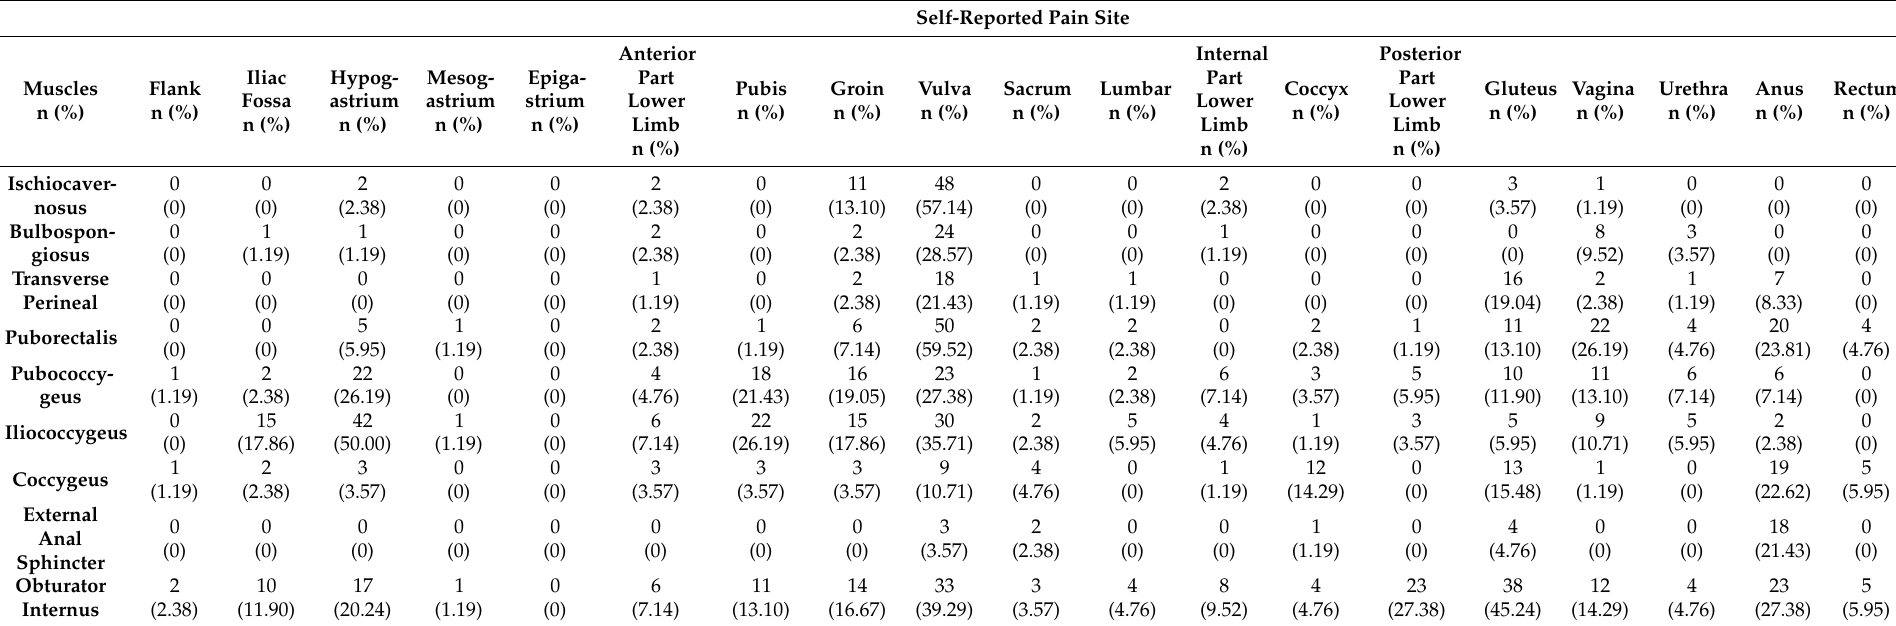
Table 12. Pain reproduced at specific sites after palpation in 84 participants during ovulatory phase in the pelvic floor